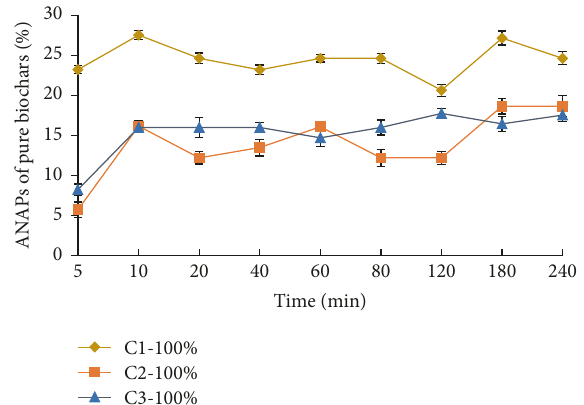
trend was found for 5%, 10%, and 15% nut shell carbon except for 20%.